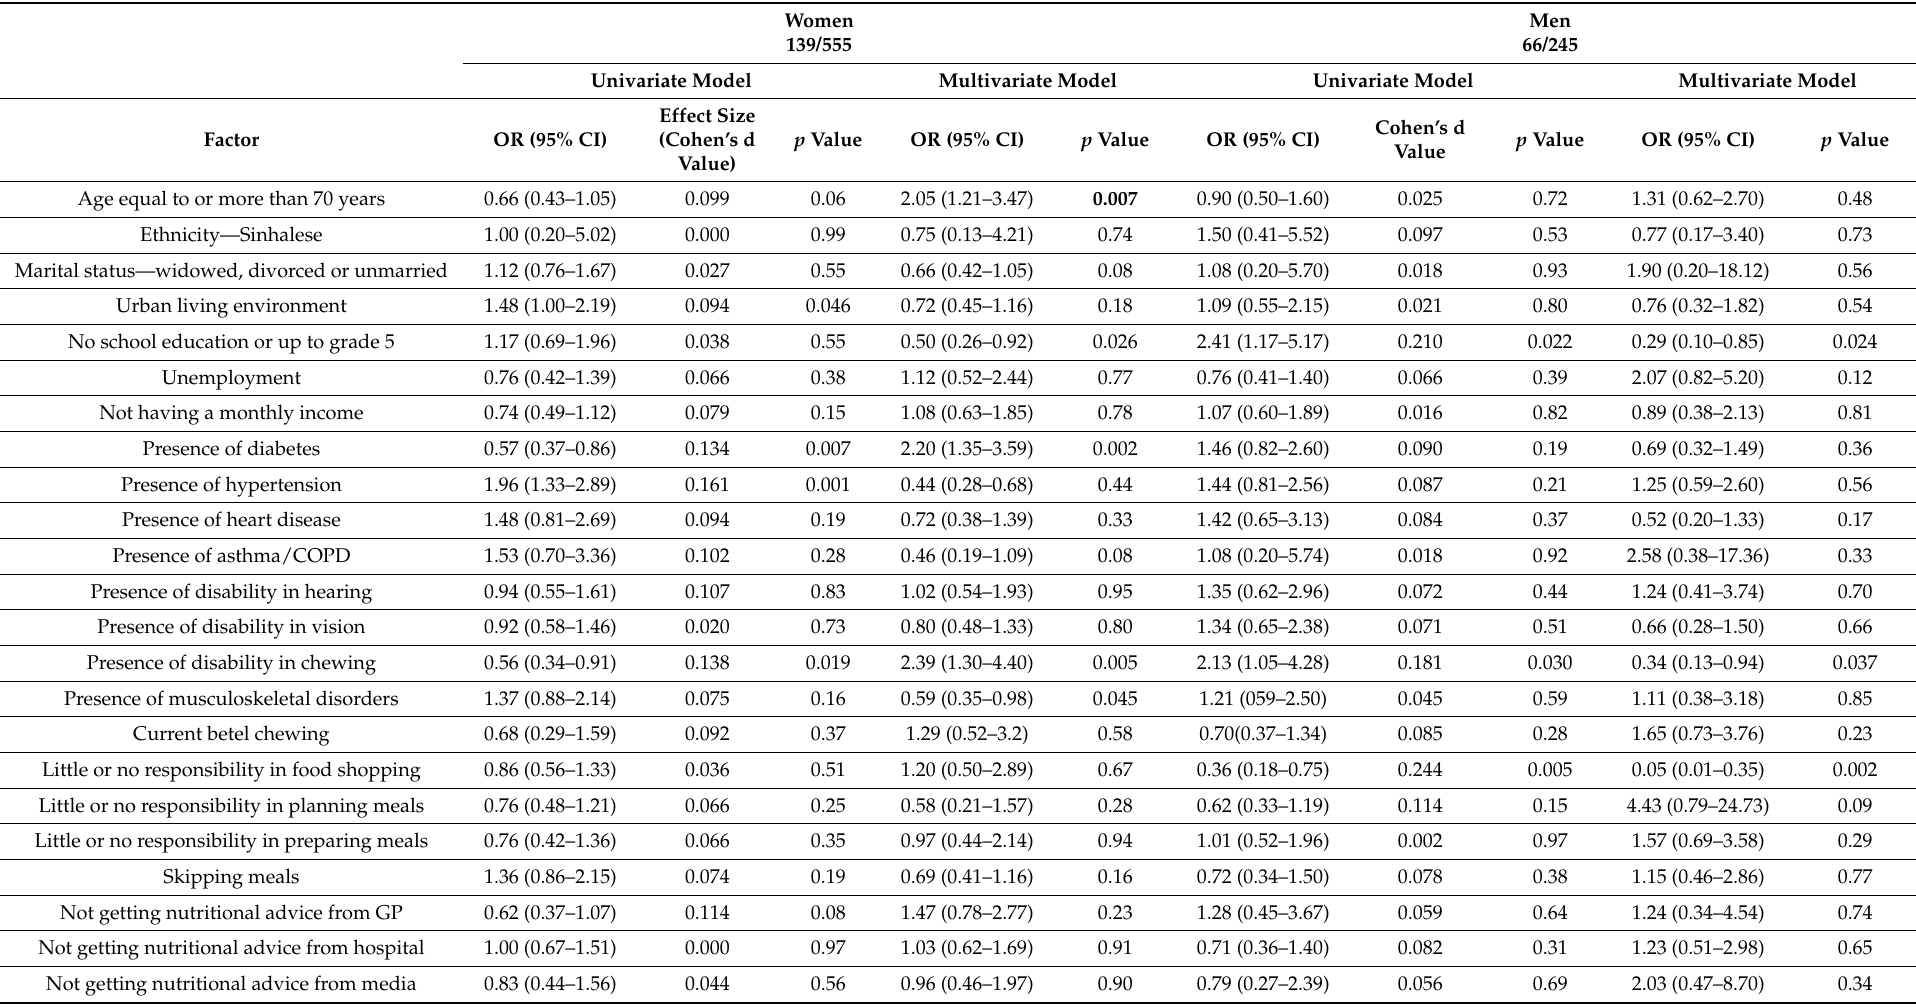
Table 4. Univariate and multivariate regression analysis of associated factors, odds ratios and their likelihood for high fat mass among older men and